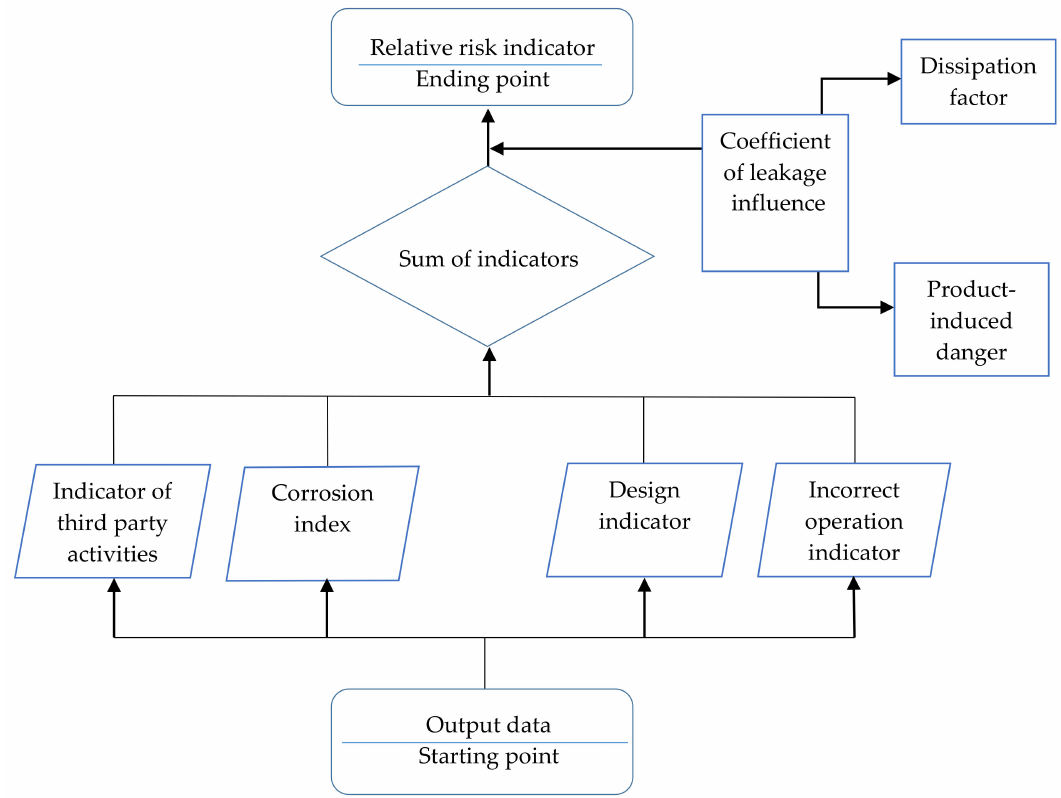
Figure 2. Model for gas network operation risk assessment on the basis of Muhlbauer